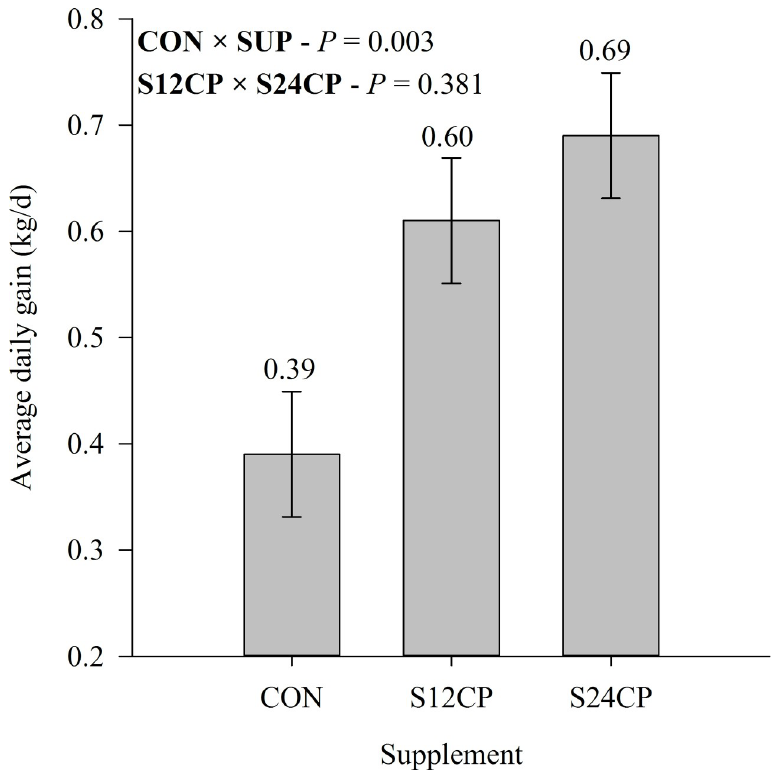
Fig 2. Average daily gain of Holstein x Gyr crossbred heifers on a rotational grazing system Panicum maximum cv. Mombac¸a pasture. � CON = not supplemented; S12CP: supplemented with concentrate containing 12% CP; S24CP: supplemented with concentrate containing 24% CP. � CON × SUP = effect of supplementation; S12CPB × S24CP = effect of supplement protein levels. https://doi.org/10.1371/journal.pone.0239786.g002 NDF intake were greater in periods 1 and 3 when compared with periods 2 and 4. The DM, CP, and NDF digestibility were greater in period 1 when compared with other periods. How- ever, the EMS was lower in period 1 when compared with other periods. CP intake per DMI (CPI/DMI) presented a treatment-by-period interaction, and S24CP had the greater CPI/DMI and S12CP the lowest CPI/DMI in all periods ( P = 0.005; Table 3). The ADG ( P = 0.003; Fig 2) and rib eye area ( P = 0.040; Table 4) were affected by supple- mentation, and SUP had greater ADG and rib eye area when compared with CON. We also Table 4. Carcass trait and mammary gland pixels’ pattern of Holstein × Gyr crossbred heifers on a rotational grazing system Panicum maximum cv. Mombac¸a pasture.